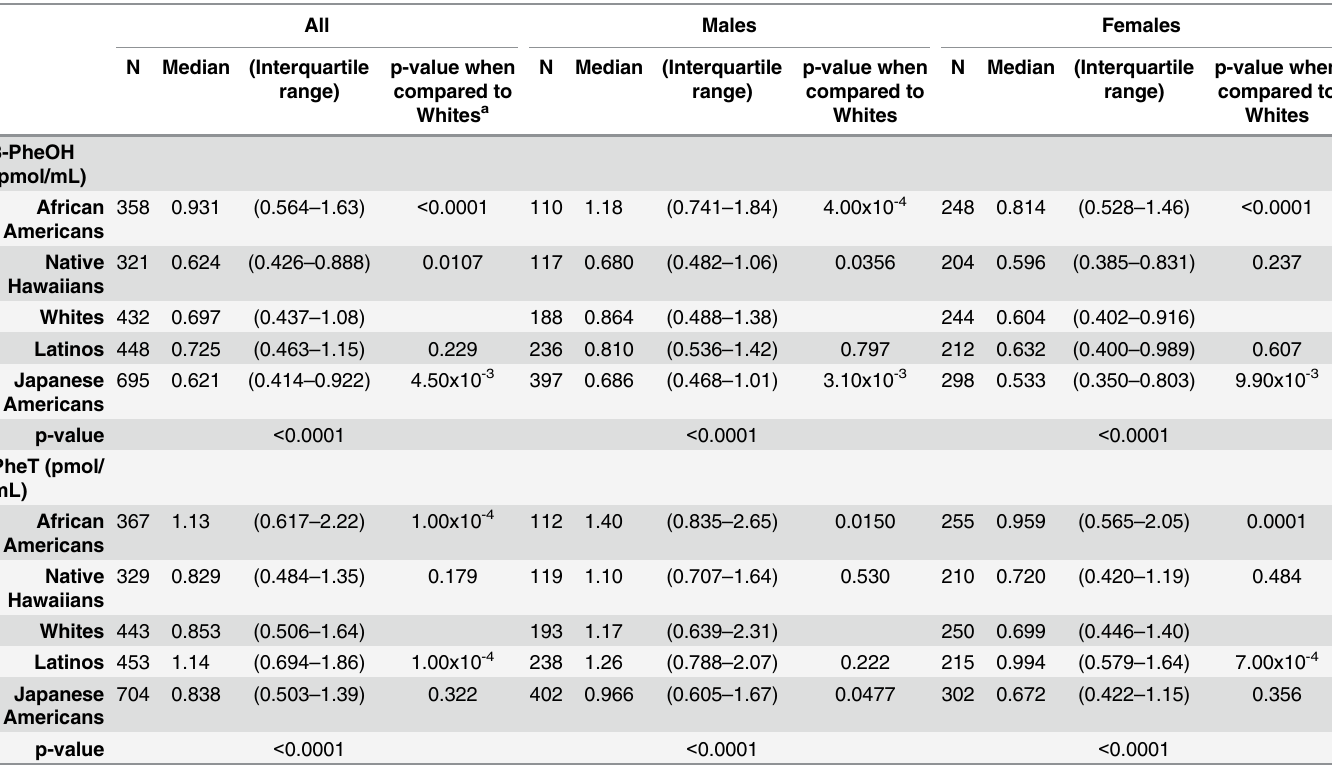
Table 3. Median and interquartile range for measures of 3-PheOH and PheT. All Males Females N Median (Interquartile